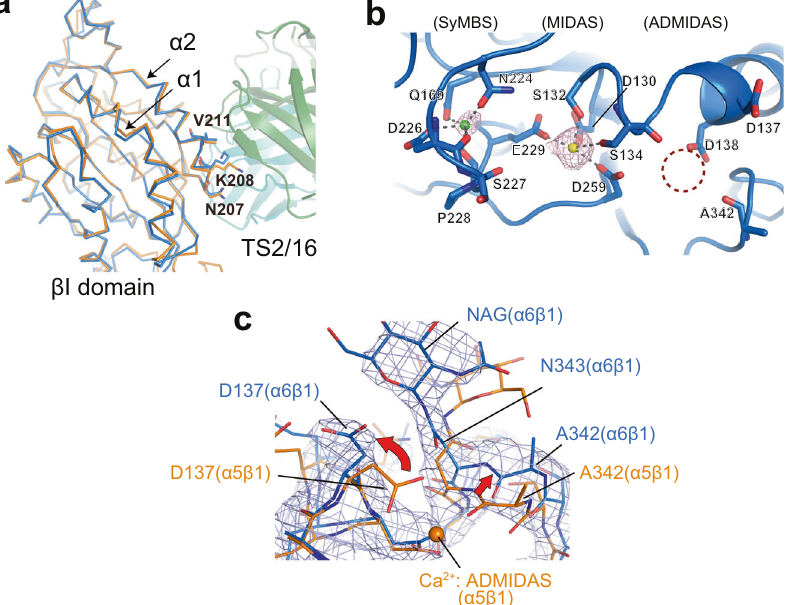
Fig. 2 Structure of the β I domain. a Structural comparison of β 1 integrins before and after the TS2/16 binding. The β 1 subunit portions from the TS2/16- bound α 6 β 1 headpiece (sky blue) and the unbound α 5 β 1 headpiece (PDB ID:4wjk, orange) are superposed at the β I domain and shown as C α -tracing. TS2/ 16 Fv-clasp bound to α 6 β 1 is shown as a translucent ribbon diagram. The α 2 helix of β I domain harboring TS2/16 epitope residues (N207/K208/V211) and the adjacent α 1 helix are labeled. b Metal ion coordination sites in the α 6 β 1 headpiece structure. Simulated-annealing F o - F c omit map for metal ions contoured at 2.5 σ is shown in magenta. Ca 2 + and Mg 2 + ions assigned in the SyMBS and the MIDAS are shown as green and yellow spheres, respectively. No electron density was observed at the ADMIDAS (dotted circle). c 2 F o - F c electron density map contoured at 1.2 σ around the ADMIDAS region in the crystal structure of the α 6 β 1-TS2/16 Fv-clasp complex (sky blue), superposed onto the α 5 β 1 headpiece structure (orange) as in a . Ca 2 + ion bound to the α 5 β 1 headpiece is shown as an orange